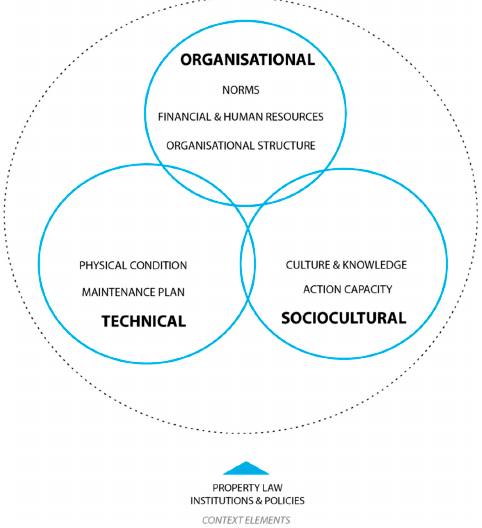
Figure 1. Housing management dimensions and elements. Source: author’s image.